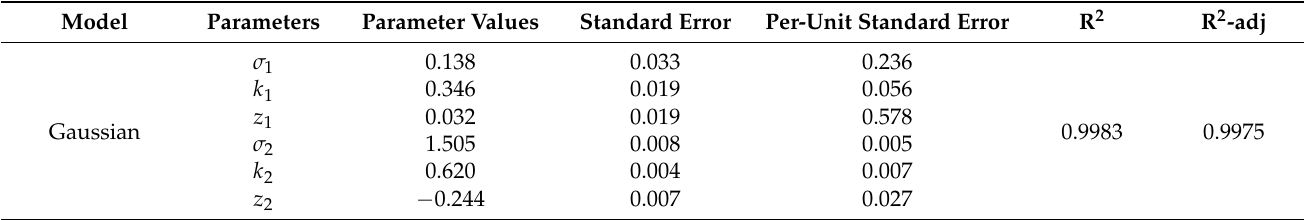
Table 5. Gaussian fitting performance data (n =